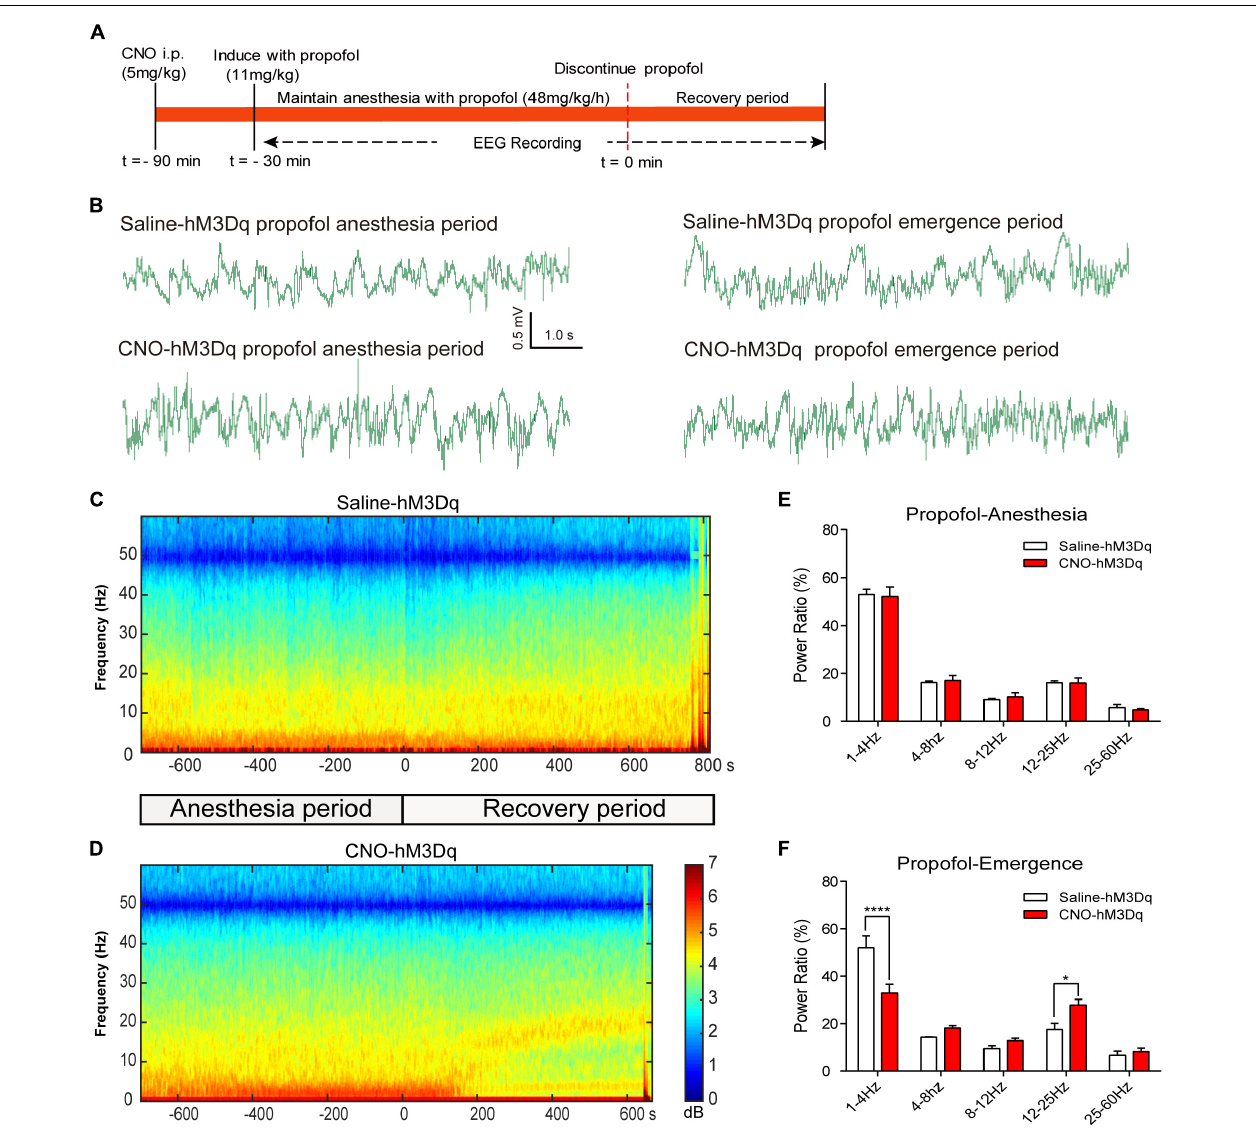
FIGURE 4 | EEG changes under PBN activation in propofol anesthesia. (A) Timeline for EEG recording in propofol anesthesia. (B) Representative EEG traces during anesthesia and emergence period in hM3Dq rats pretreated with CNO or saline. (C,D) Spectrograms of EEG power during propofol anesthesia and emergence period after delivery of saline (C) or CNO (D) i.p. 0 on the time axis indicates the cession of propofol infusion. Warm colors (e.g., red) represent higher power at a given frequency, whereas cool colors (e.g., blue) represent lower power. (E) In the propofol anesthesia period, EEG traces 5 min before cessation of anesthetic were compared. No significant difference was found between CNO and saline use in any of the frequency bands quantified ( F 4 , 50 = 0.1241, p = 0.9731, two-way ANOVA). (F) In the recovery period, power spectrum analysis was conducted on data from propofol infusion stop to 5 min after that. CNO i.p. injection in hM3Dq rats shows a significant difference compared to the hM3Dq-saline group, displaying a significant decrease in δ power (1–4 Hz) and an increase in β power (12–25 Hz). All summary graphs show mean ± SEM ( n = 6); ∗ p < 0.05 and ∗∗∗∗ p < 0.0001, Bonferroni’s post hoc test after two-way